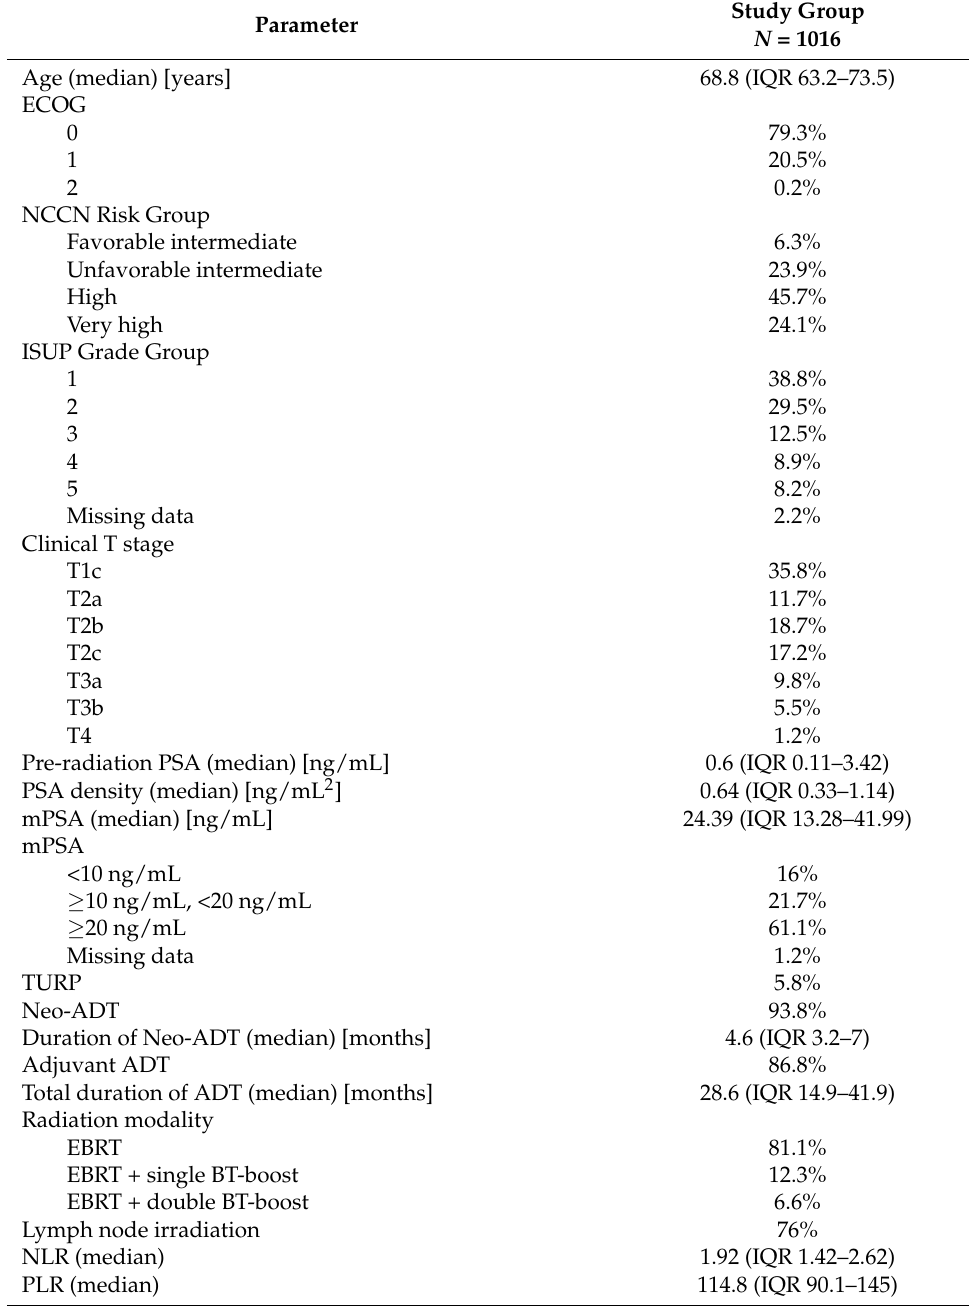
Table 1. Baseline patient